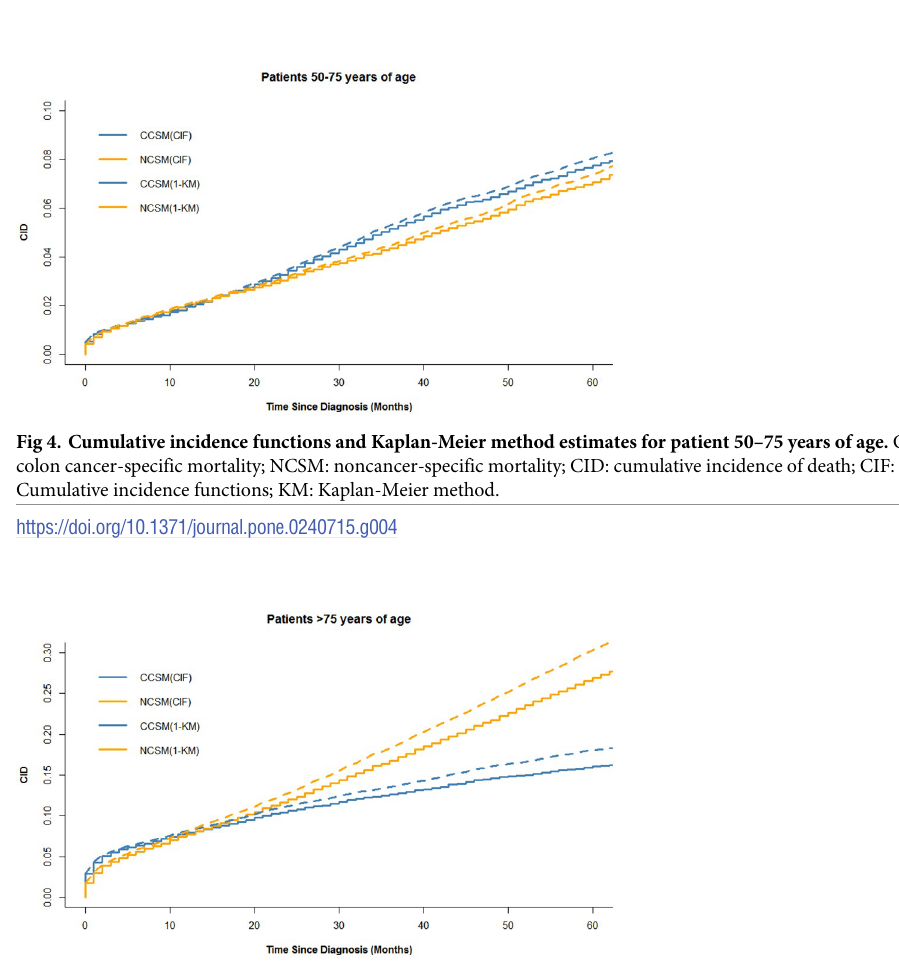
Fig 5. Cumulative incidence functions and Kaplan-Meier method estimates for patient > 75 years of age. CCSM: colon cancer-specific mortality; NCSM: noncancer-specific mortality; CID: cumulative incidence of death; CIF: Cumulative incidence functions; KM: Kaplan-Meier method.